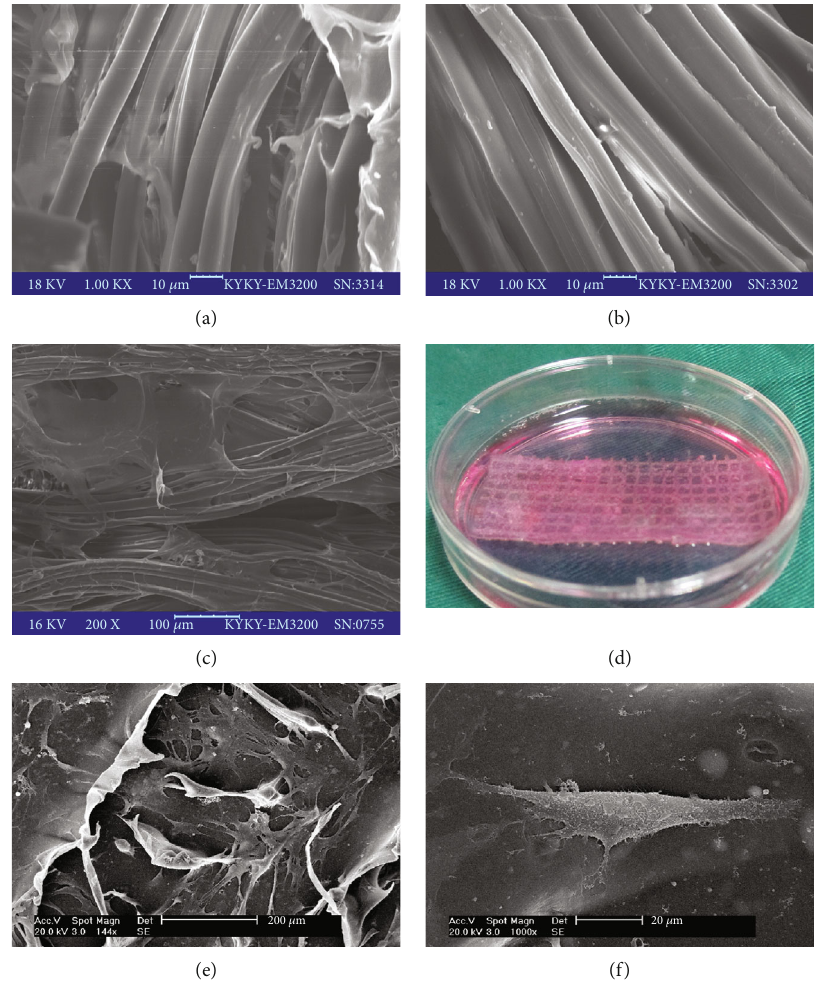
Figure 2: (a) The microstructure of silk fi bers before degumming: the surface is coated with the glue-like protein sericin. (b) Under SEM, the surface of silk fi broins becomes smooth after complete degumming; the average diameter is about 10 μ m. (c) The microstructure of silk- collagen sca ff old after the dehydrothermal crosslinking process: the collagen sponge permeated into the rings of knitted mesh. (d) BMSCs were seeded on the sca ff old and cocultured for 72h for further use. (e) BMSCs exhibited vigorous proliferation on the sca ff old. (f) BMSCs retained good cellular morphology on the sca ff old observed by